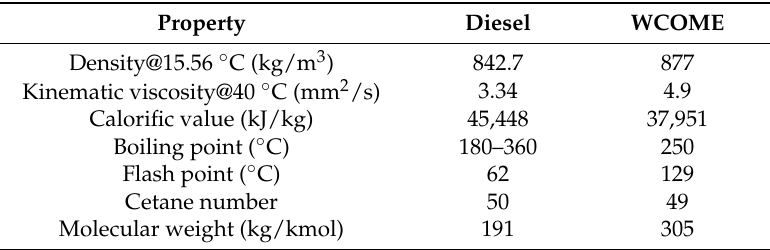
Table 5. Properties of the test fuels